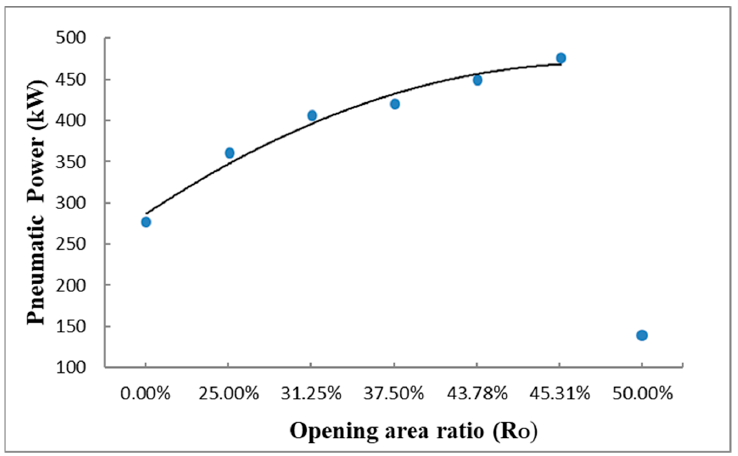
Figure 16. Pneumatic power corresponding to opening ratio of OWC gate.